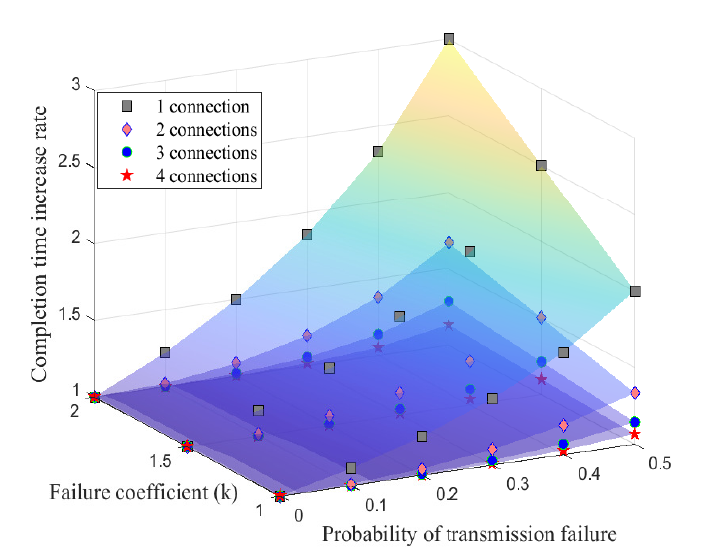
Figure 4. Completion time analysis.